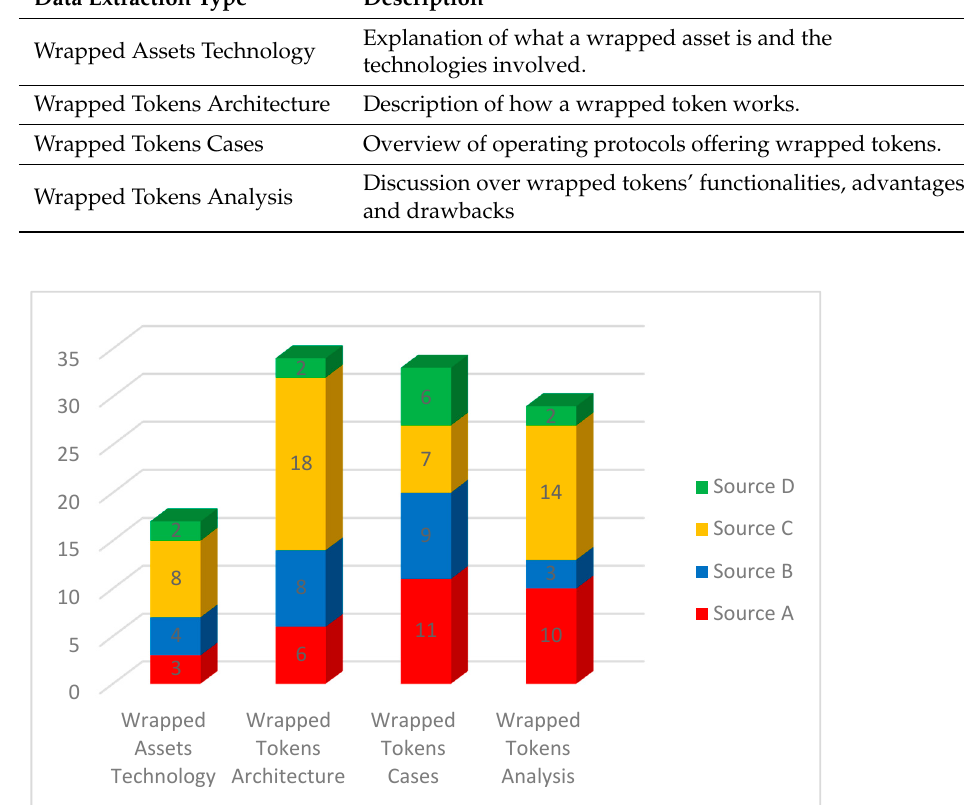
Figure 2. Contributions by resource.